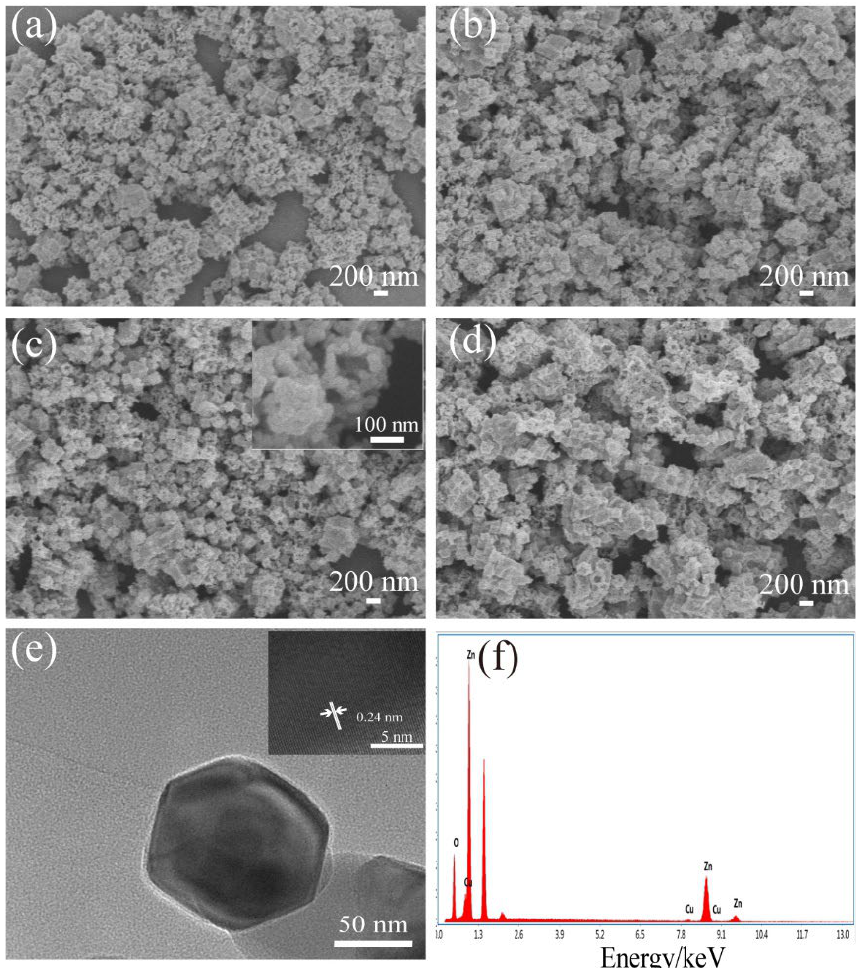
Figure 4. SEM images of the samples: ( a ) pure ZnO nanocages, ( b – d ) Cu-doped ZnO nanocages with different Cu contents (1 at%, 3 at%, 5 at%), ( e ) TEM image, the inset in ( e ) is an HRTEM image and ( f ) EDS spectra of 3 at% Cu-doped ZnO nanocages.